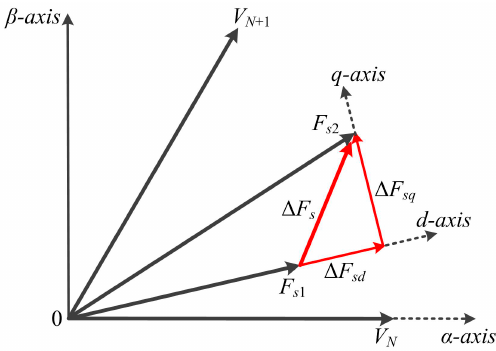
Figure 3. Analysis of error compensational effects.